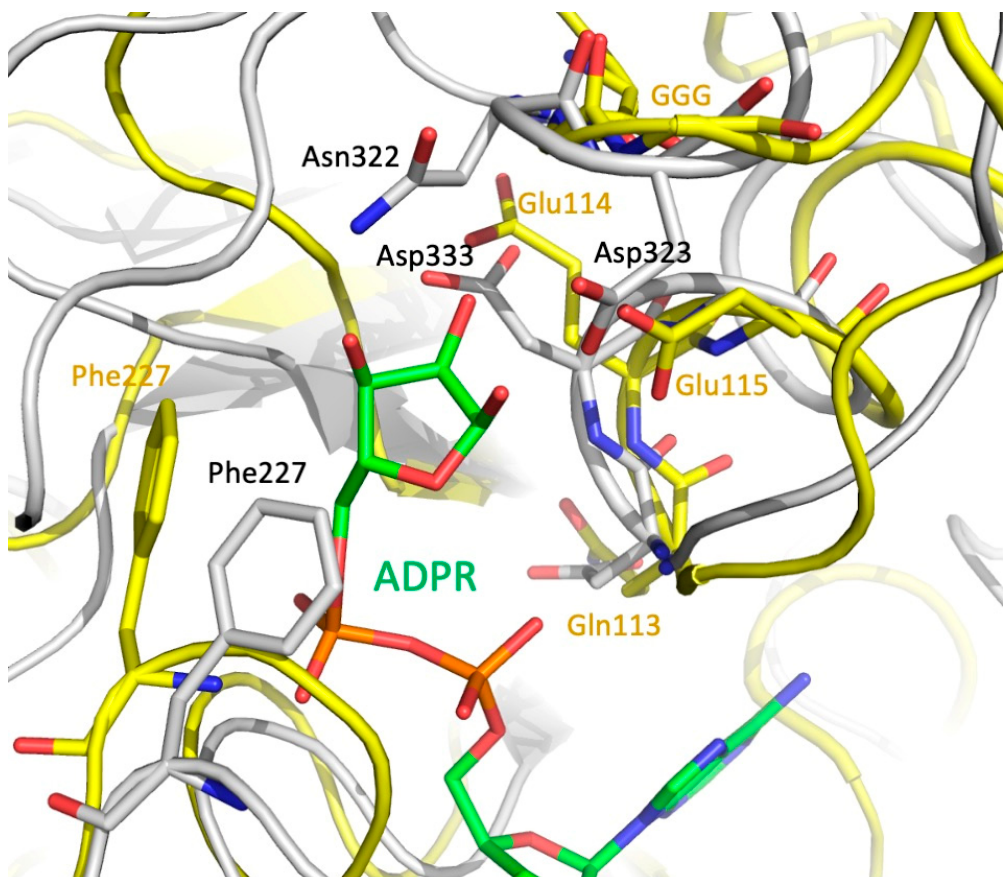
Figure 6. Optimal superposition of the eraser macrodomain from T. curvata (PDB ID 3SIG) (yellow backbone, green ADPR) and MavL (gray backbone). Closeup of the ribose-binding site. Sidechains of the GGG—QEE (Gln113Glu114Glu115) motif, the Phe sidechain in the eraser macrodomain, and the acidic residues and Phe in MavL are shown in stick mode. There are clear spatial similarities in positions of the key catalytic residues in macrodomain and the putative catalytic residues in MavL.